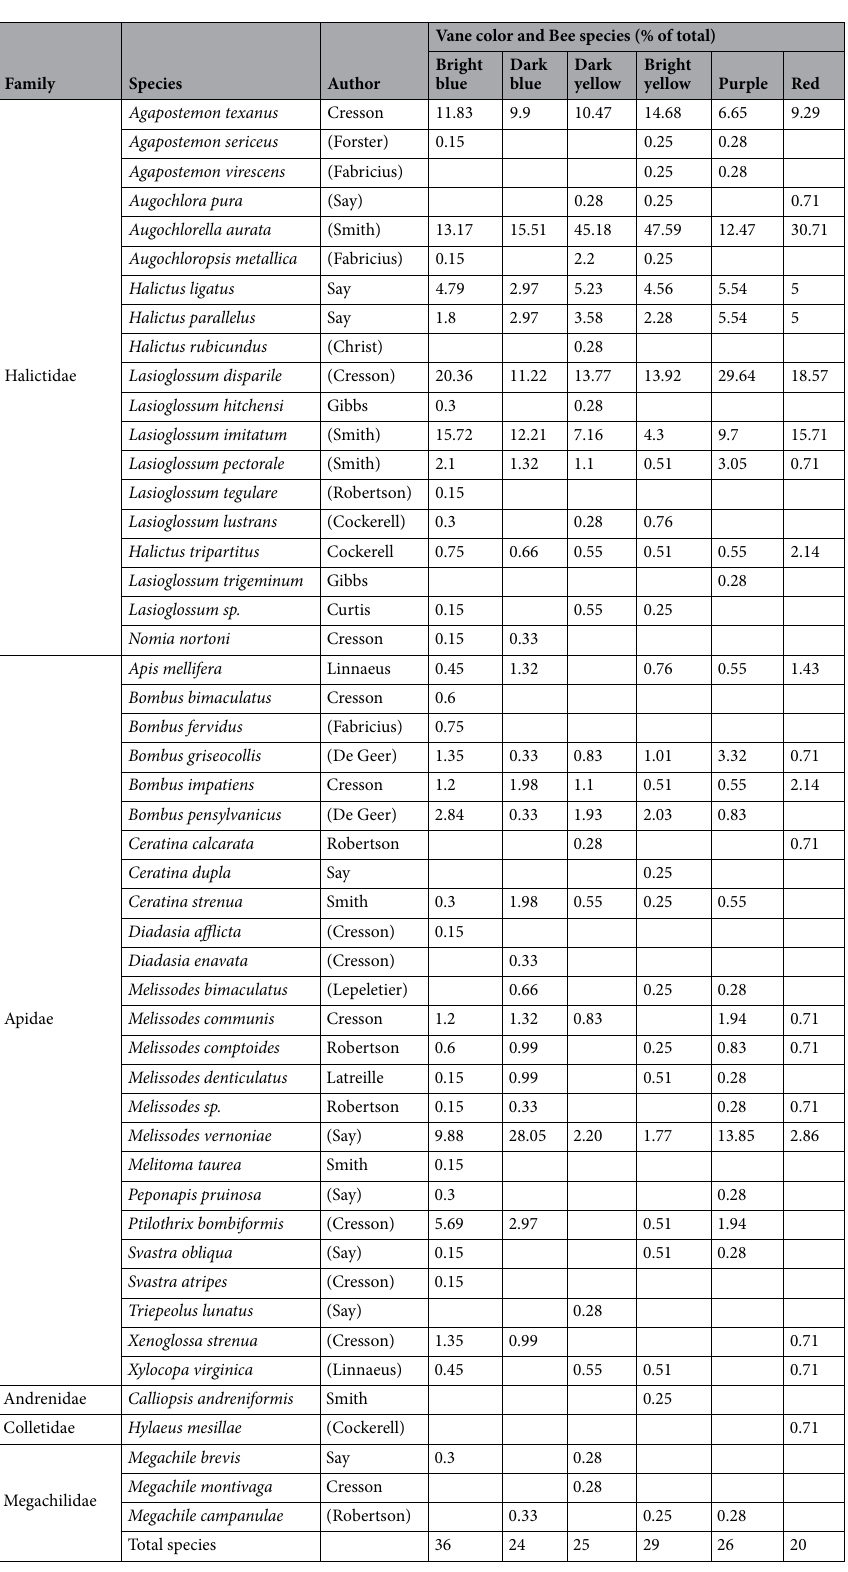
Table 1. Family and species list of bees collected in passive traps with different colored (bright blue, dark blue, dark yellow, bright yellow, purple, and red) vanes. Percent abundance of total species in each trap is